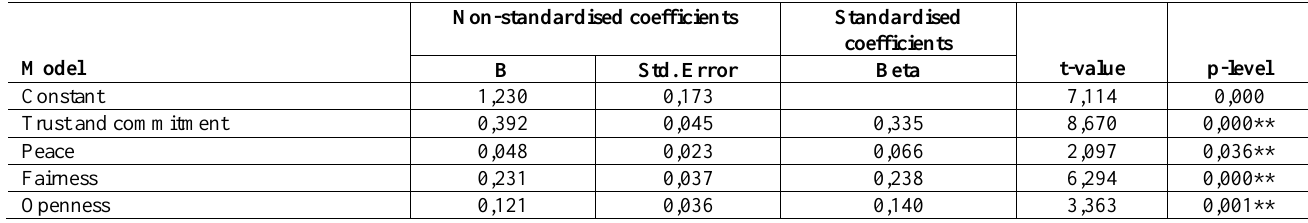
Table 4: Multiple regression results: Impact of the business values Trust and commitment , Peace , Fairness and Openness on the dependent variable Perceived future